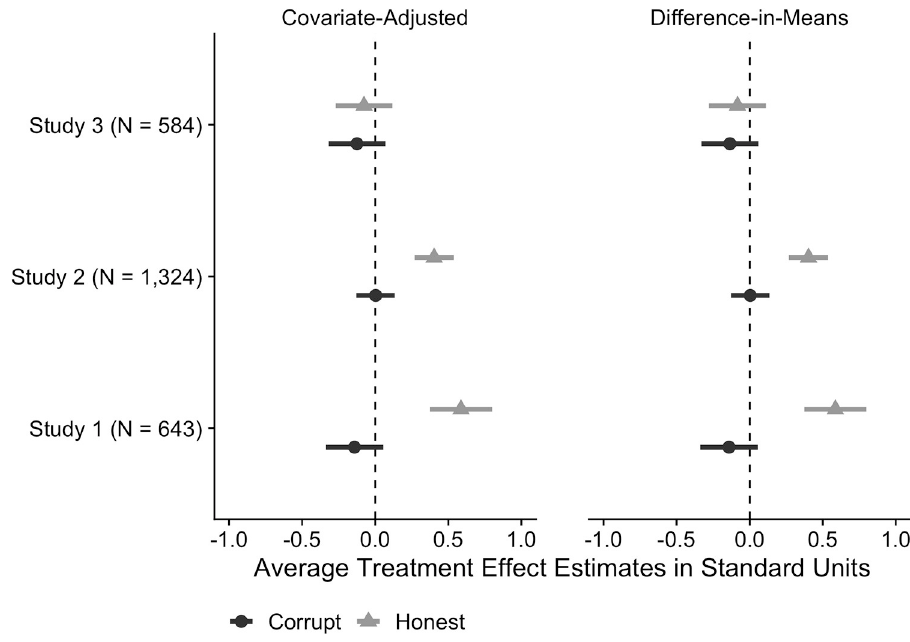
Dependent Variable: Political Trust (Likert Scale)